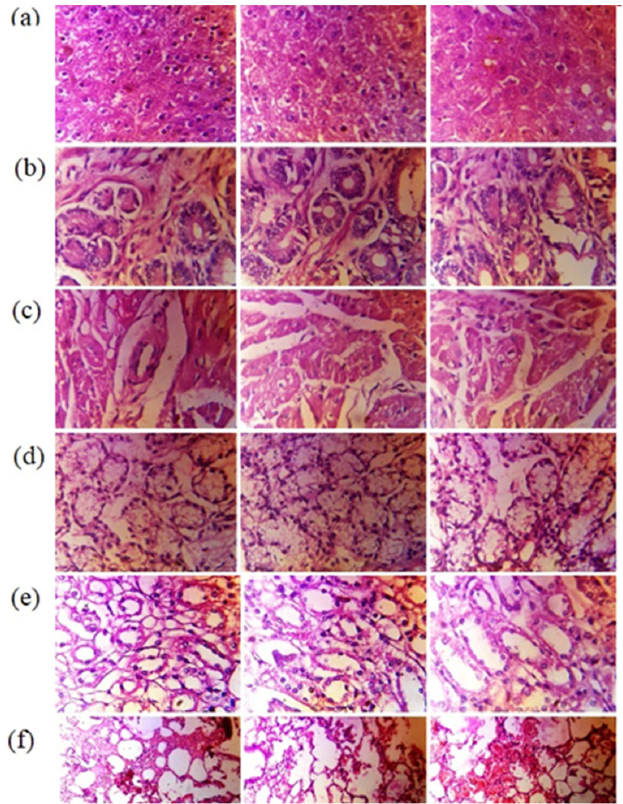
Figure 10. Histopathological examination of rabbit organs of Liver ( a ), stomach ( b ) heart ( c ), large intestine ( d ), kidney ( e ) and lungs ( f ).